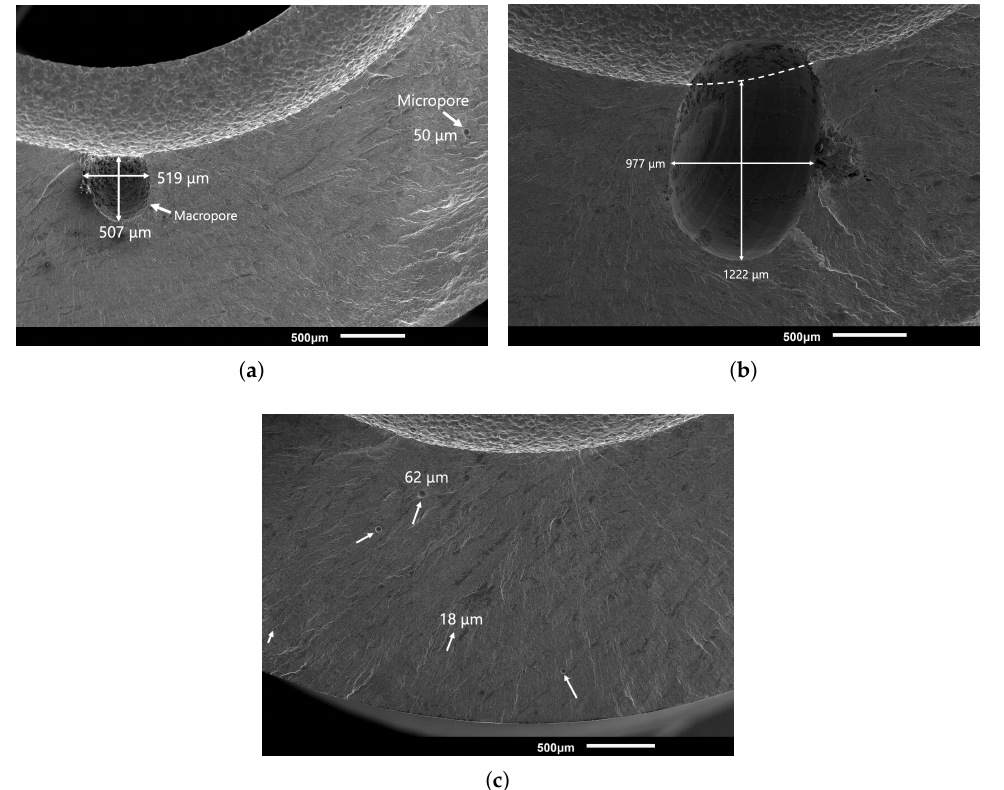
Figure 10. Macro- and micropore identification of weld metal specimens. ( a ) An overview of a macropore located at the notch. ( b ) Zoomed-in projection of another 150 barg H 2 defected weld metal specimen with a macropore located on the notch root. ( c ) Micropores in a 150 barg N 2 weld metal specimen. The micropores had a diameter between 10–100 µm.